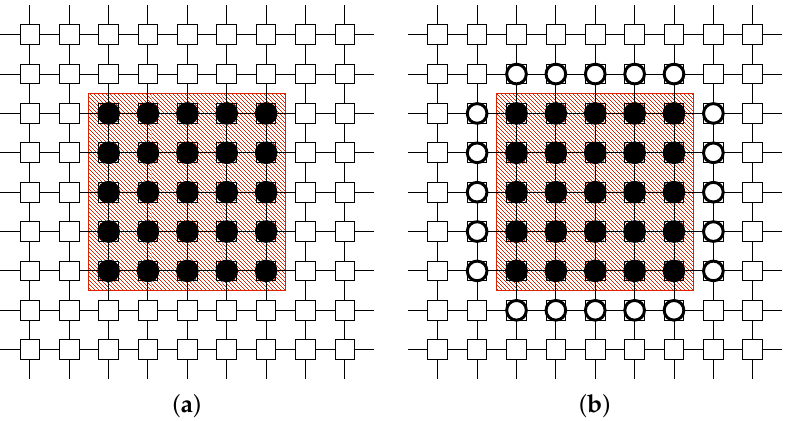
Figure 4. Application example of surrounding tactic for Danger Zone. ( a ) Before. The red area represents a Danger Zone. ( b ) After. The white-hat worms are placed to surround the